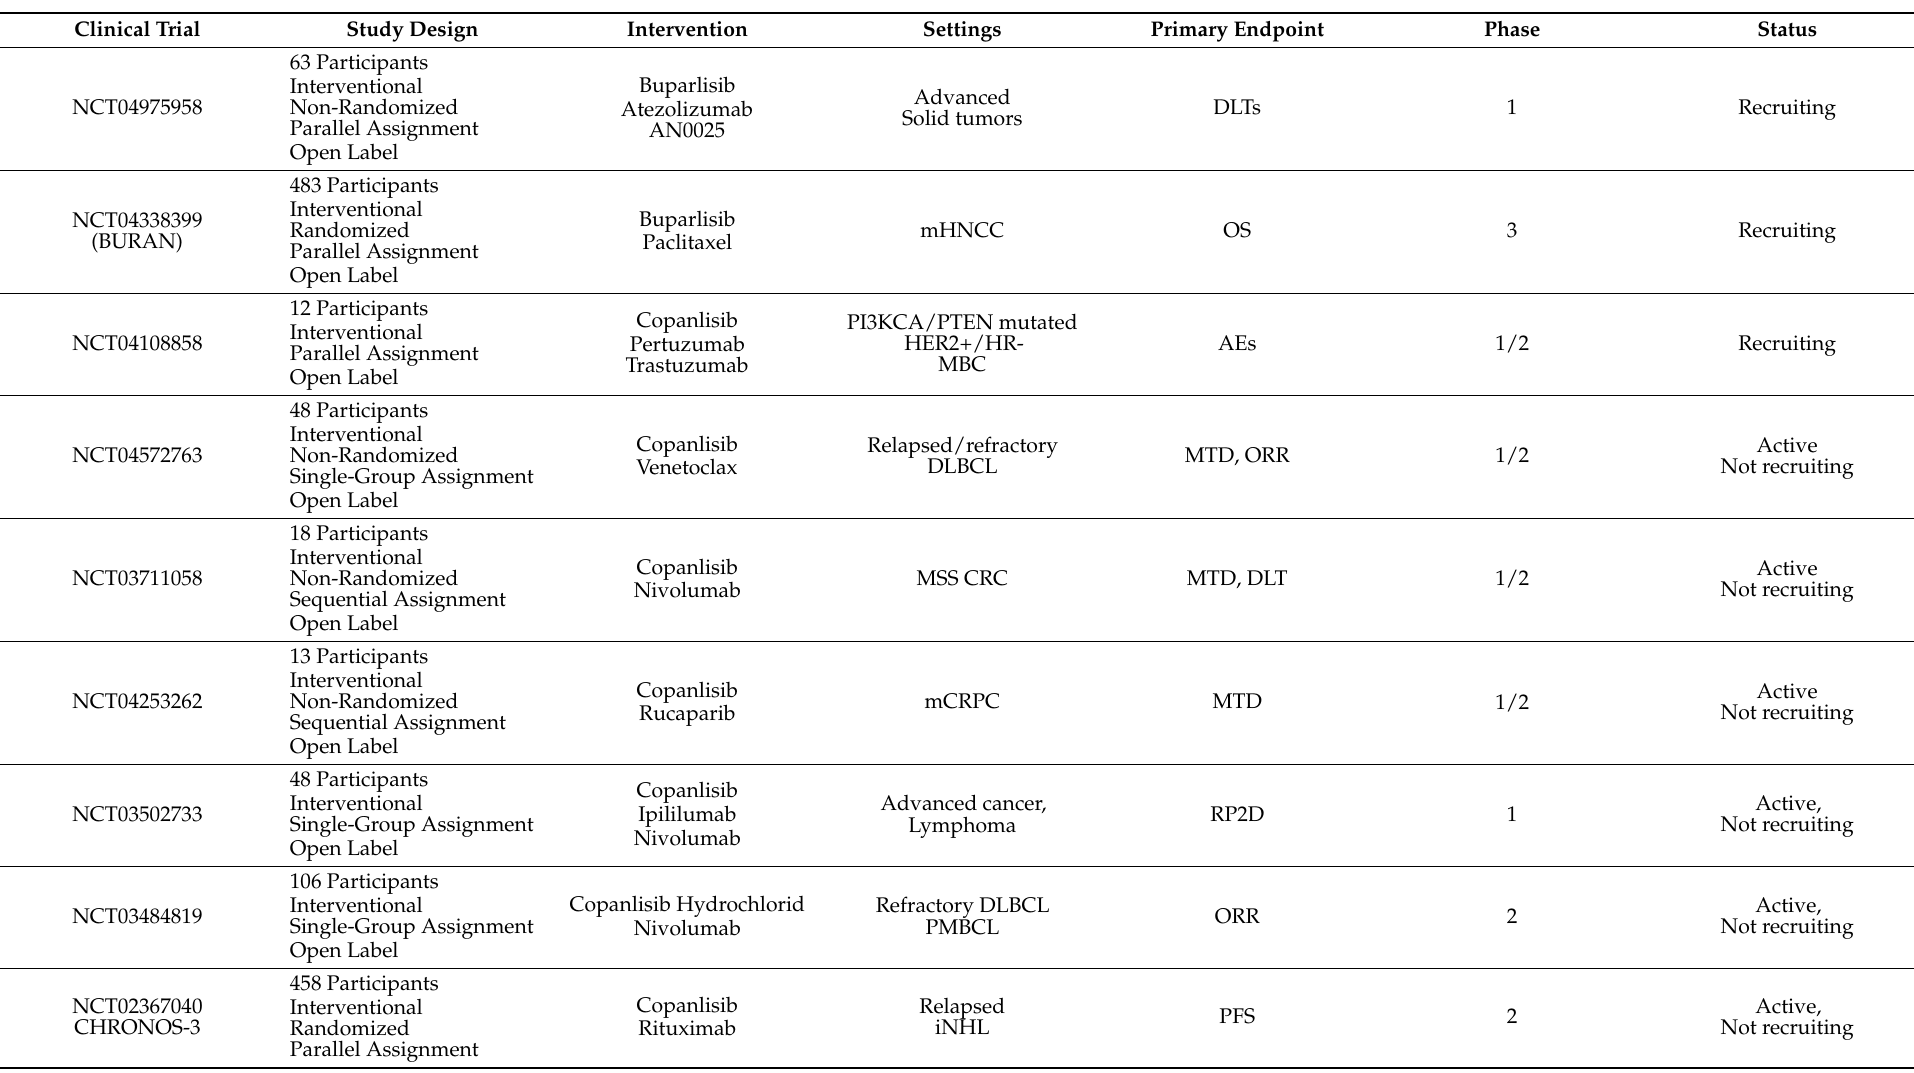
Table 1. Summary of ongoing phases I–III trials with PI3k inhibitors in solid